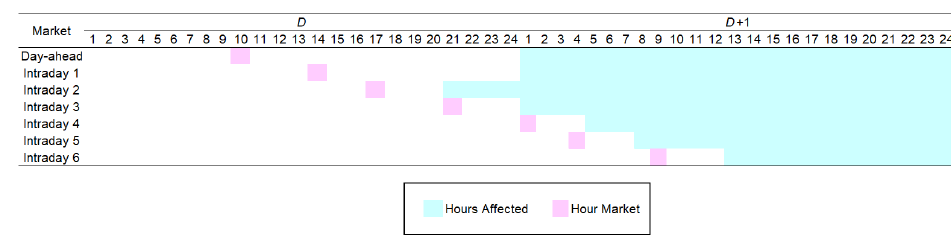
Figure 1. Spanish electricity